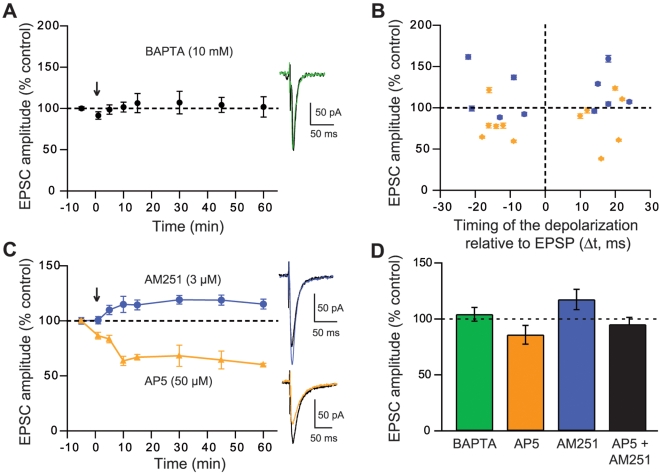
Pharmacological characterization of SDDP.(A) sdLTD and sdLTP are Ca2+-dependent. Mean effects of BAPTA for −50<Δt<+50 ms post-pre and pre-post SDDP sequences. When MSNs were loaded with BAPTA (10 mM, in whole-cell pipettes), SDDP protocols did not induce any long-term synaptic efficacy changes (+4.2±9.1%, n = 6, −50<Δt<+50 ms), indicating that the SDDP is Ca2+-dependent. The absence of synaptic efficacy changes is also illustrated by representative EPSCs evoked before (black traces) or 60 minutes after SDDP sequences (green trace). (B) Pharmacology of SDDP was explored for −30<Δt<+30 ms (each symbol represent one MSN, mean±SEM measured 60 minutes after cellular conditioning protocol). AP5 treatment (orange diamonds, n = 10) induces mainly sdLTD for post-pre and pre-post sequences. Treatment with AM251 (purple dots, n = 8) leads to sdLTP or absence of plasticity. (C) Representative experiments illustrate the effect of treatments with AM251 or AP5. In presence of AP5 (orange trace), a sdLTD is observed (−35.6±8.1%) and with AM251 treatment (purple trace), a sdLTP is observed (+18.8±4.6%). Representative EPSCs evoked before (black traces) or 60 minutes after SDDP sequences (orange or purple traces) also illustrate the long-term plasticity observed in presence of AP5 (sdLTD) or in presence of AM251 (sdLTP). (D) Histograms of long-term synaptic efficacy changes in BAPTA (green bars, n = 6), AP5 (orange bars, n = 12), AM251 (purple bars, n = 10) and with co-administration of AP5 and AM251 (black bars, n = 4): synaptic plasticity was Ca2+-dependent, sdLTD was CB1 receptor-activation dependent and sdLTP was NMDA receptor-activation dependent. Postsynaptic depolarizations evoked during pharmacological experiments were not significantly different than those induced for post-pre and pre-post SDDP sequences (27.4±1.1 mV versus 27.9±0.9 mV, respectively).